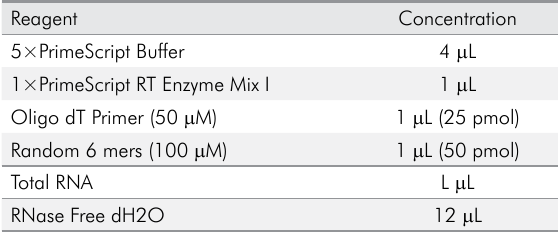
Table 1. Reverse transcription system.